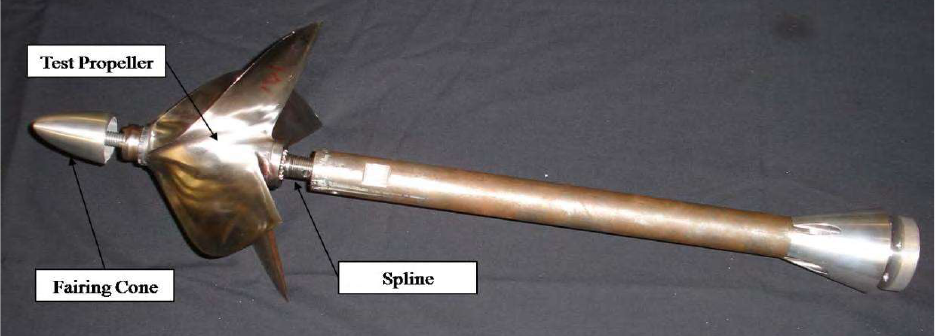
Figure 3. Test propeller with shaft assembly.